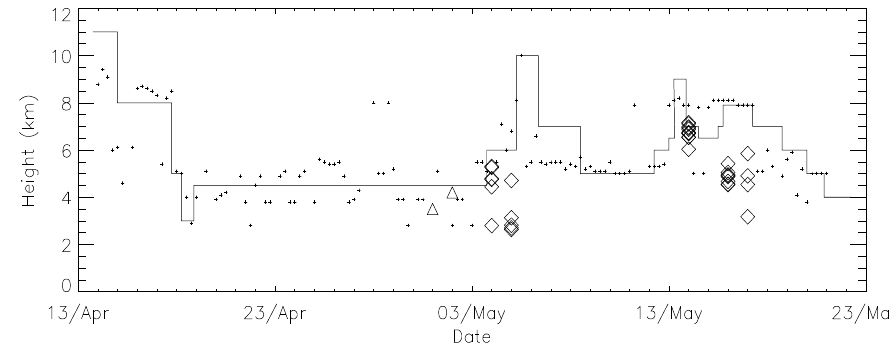
Fig. 1. Timeseries of the height of the eruption plume above sea level. Height of the eruption plume used in NAME simulations (solid line), maximum heights detected by radar (small crosses) taken from Arason et al. (2011), heights of ash layers observed by FAAM aircraft (diamonds), heights of ash layers observed by the DLR Falcon taken from Schumann et al. (2011) (triangles). of the eruption plume and the MER is taken to